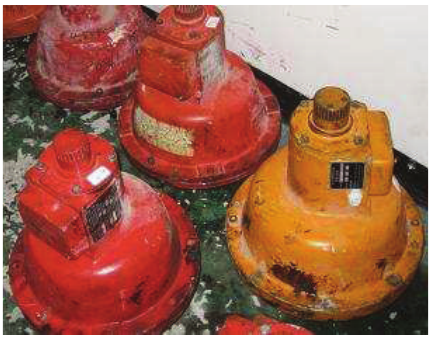
Figure 1: An antifalling safety